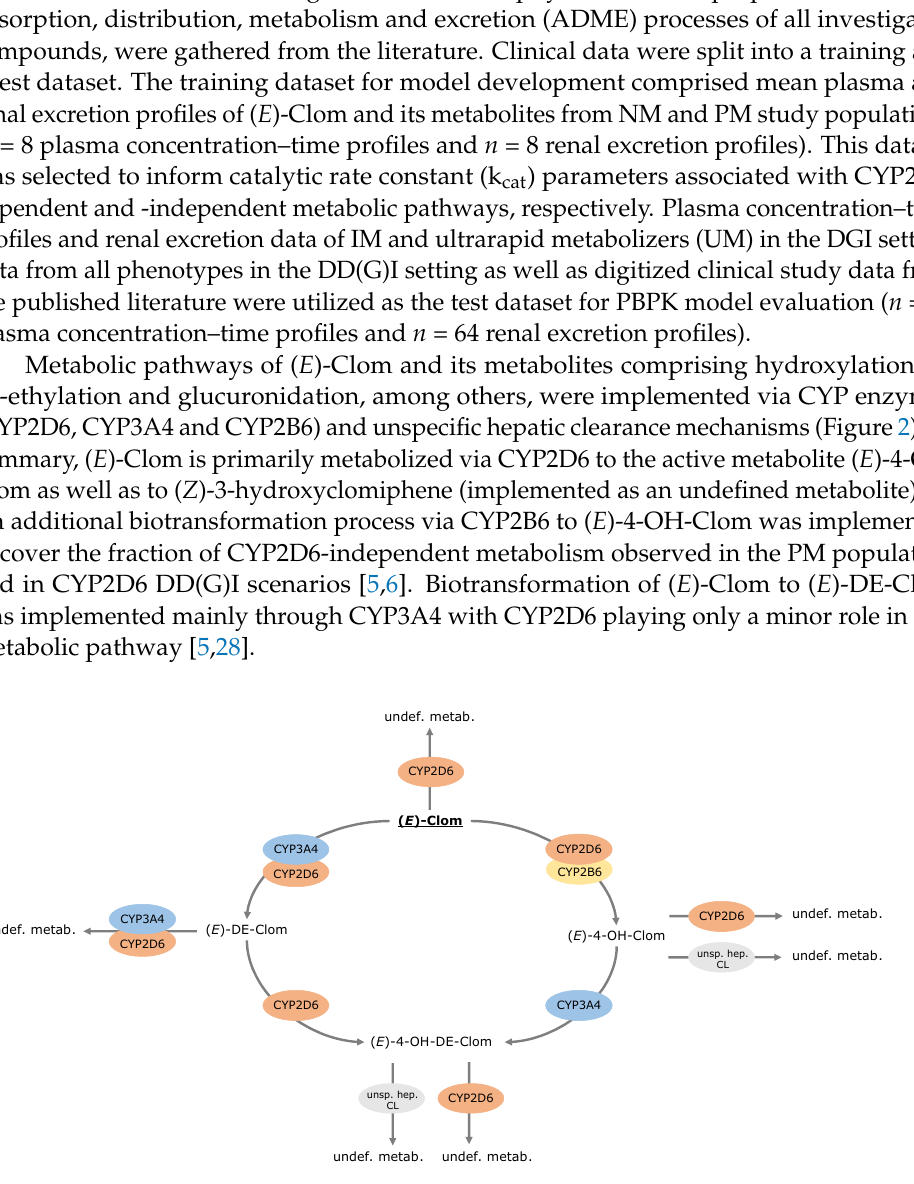
Figure 2. Overview of implemented metabolic processes in the ( E )-Clom PBPK model. CYP, cy- tochrome P450; ( E )-4-OH-Clom, ( E )-4-hydroxyclomiphene; ( E )-4-OH-DE-Clom, ( E )-4-hydroxy-N- desethylclomiphene; ( E )-Clom, ( E )-clomiphene; ( E )-DE-Clom, ( E )-N-desethylclomiphene; undef. metab., undefined metabolite; unsp. hep. CL, unspecific hepatic